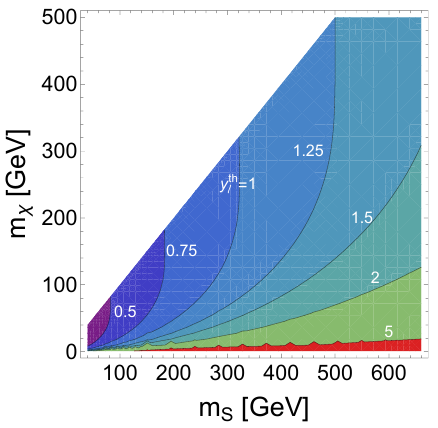
as a function of m ‘